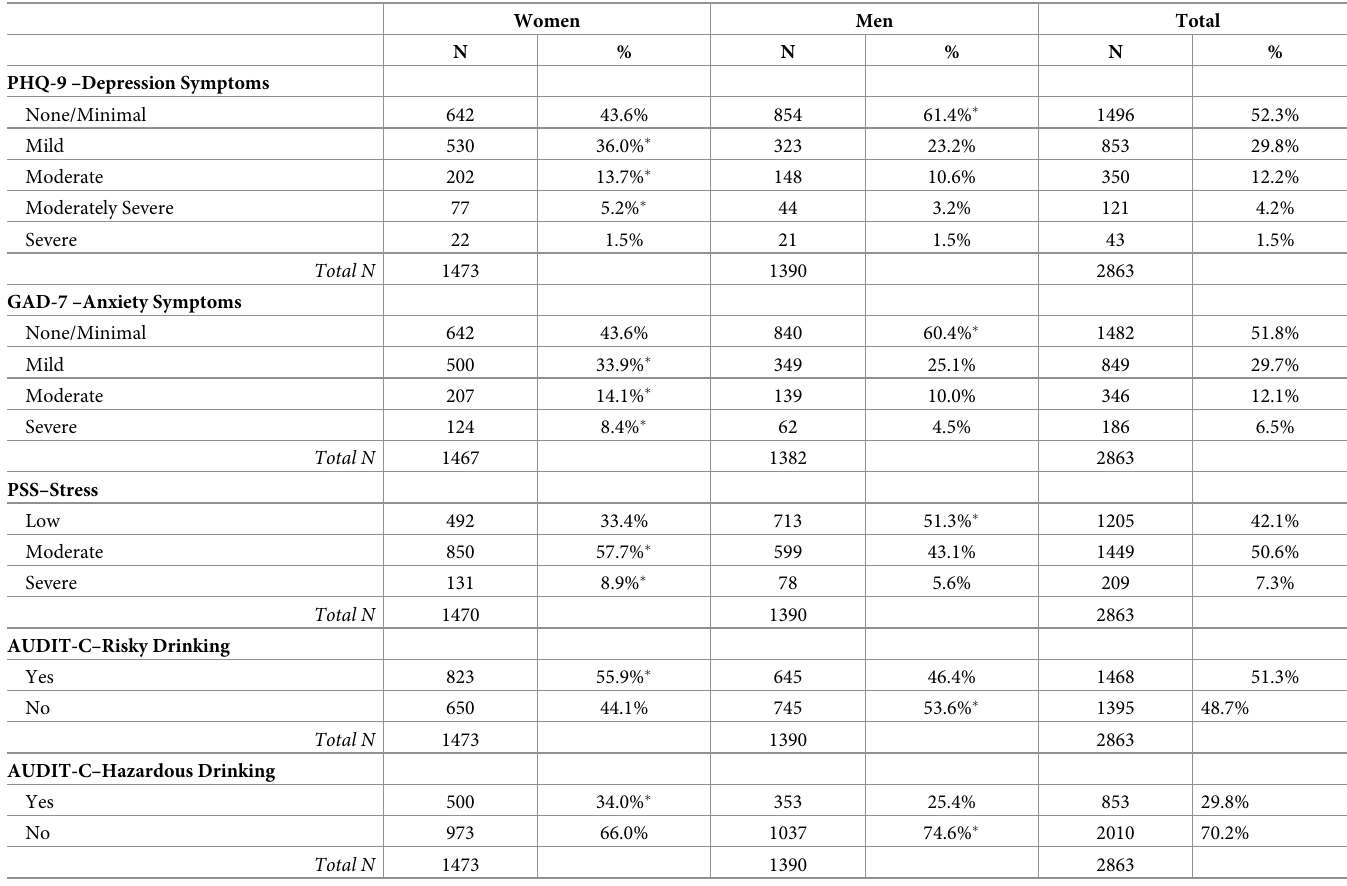
Table 3. The severity and prevalence of depression, anxiety, stress, and